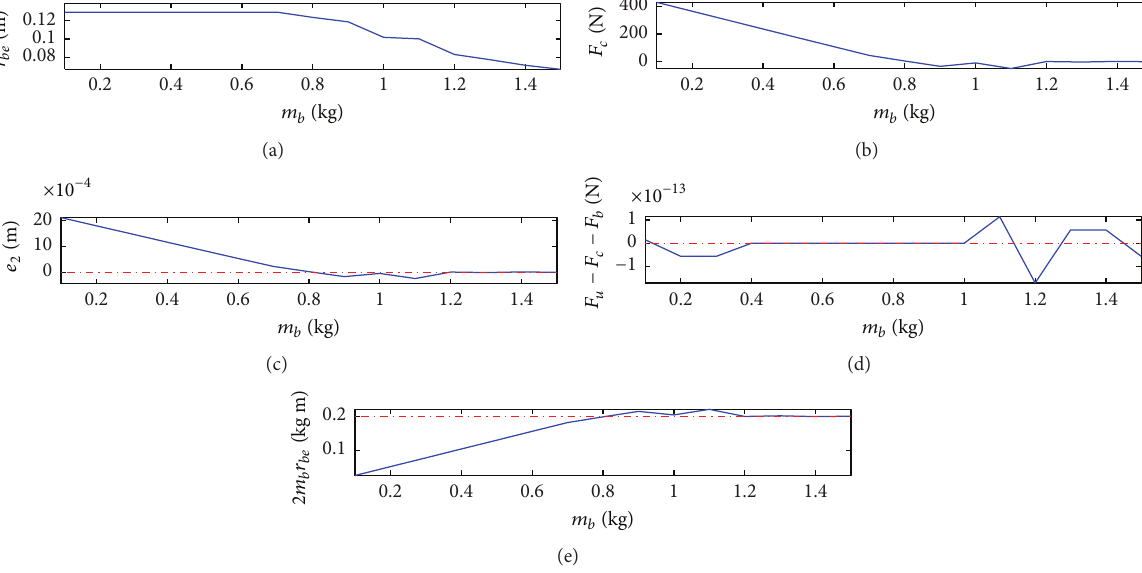
from which the critical value of 𝑚 𝑏 can be derived